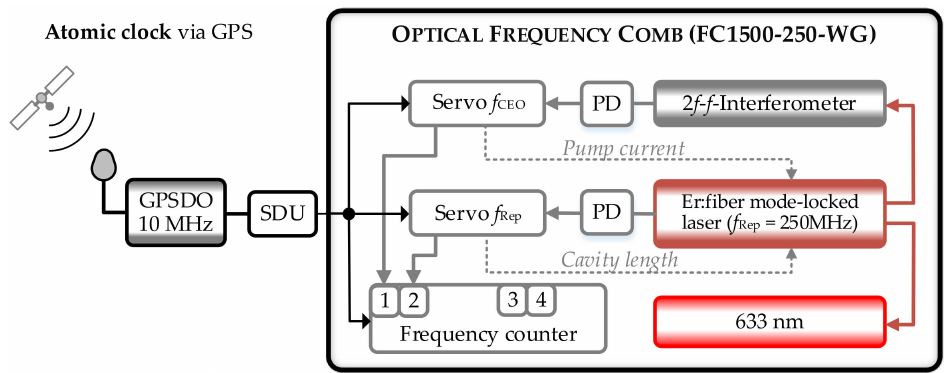
Figure 3. Structure of the GPS-referenced frequency comb at the IPMS. The abbreviations denote: OFC—optical frequency comb, GPSDO—GPS disciplined oscillator, SDU—signal distribution unit, PD—photodiode. The numbers 1–4 correspond to the respective frequency counter